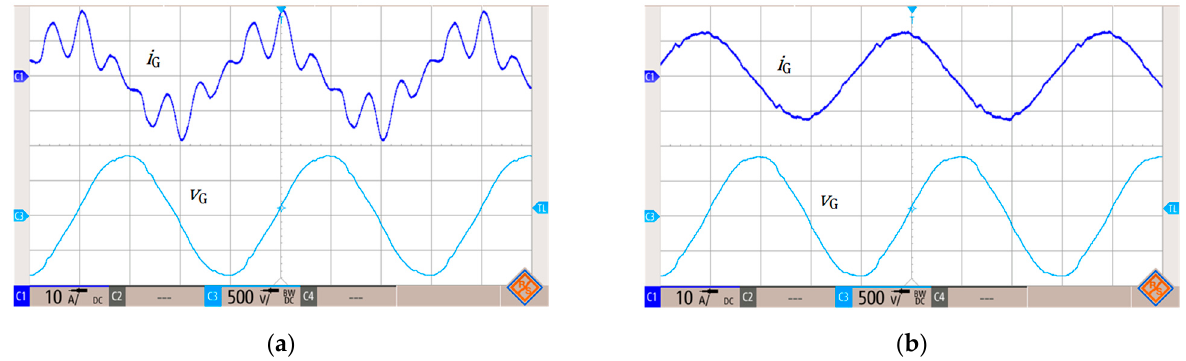
Figure 16. Compensation of the grid voltage distortions in hybrid filter: ( a ) operation without compensation with K = 0; ( b ) operation with voltage distortion compensation and K = 25.